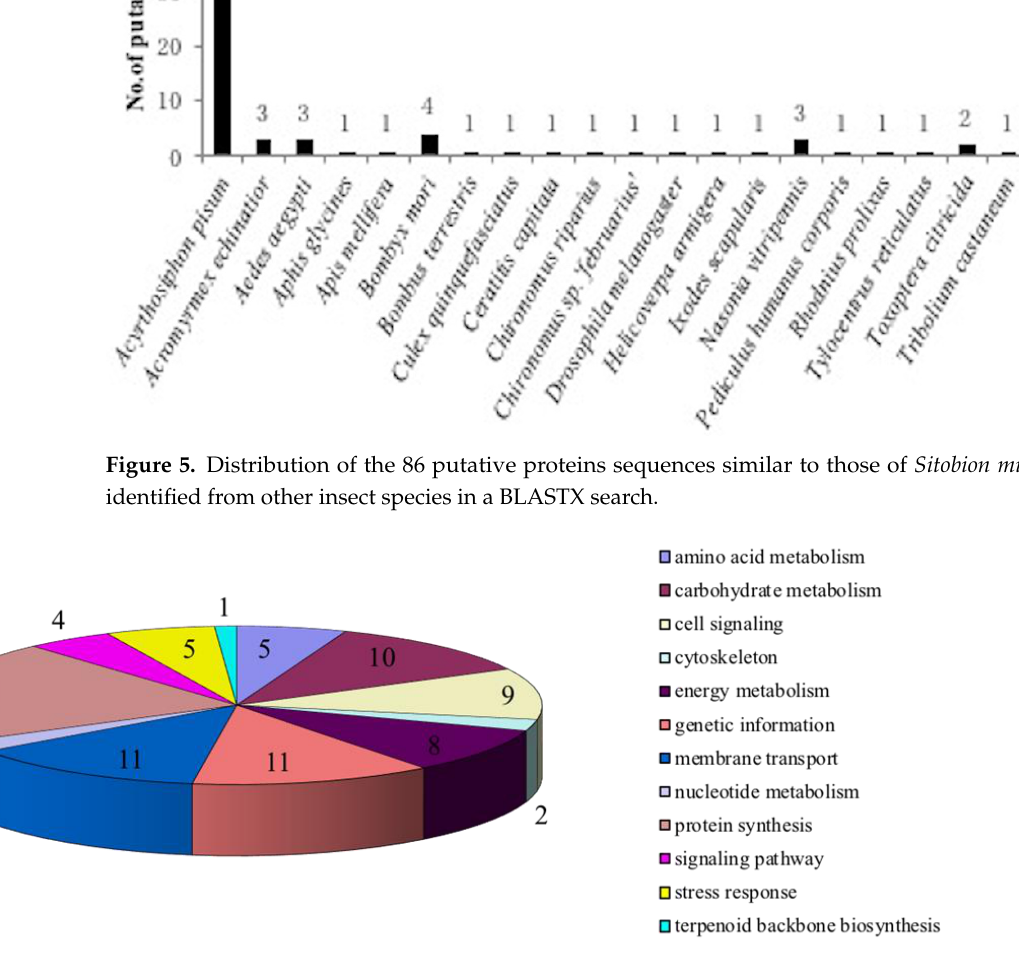
Figure 6. Pathway analysis of protein identified by 2D − DIGE gel separations from the STY geo ‐ graphic population and HDZ geographic population of Sitobion miscanthi.